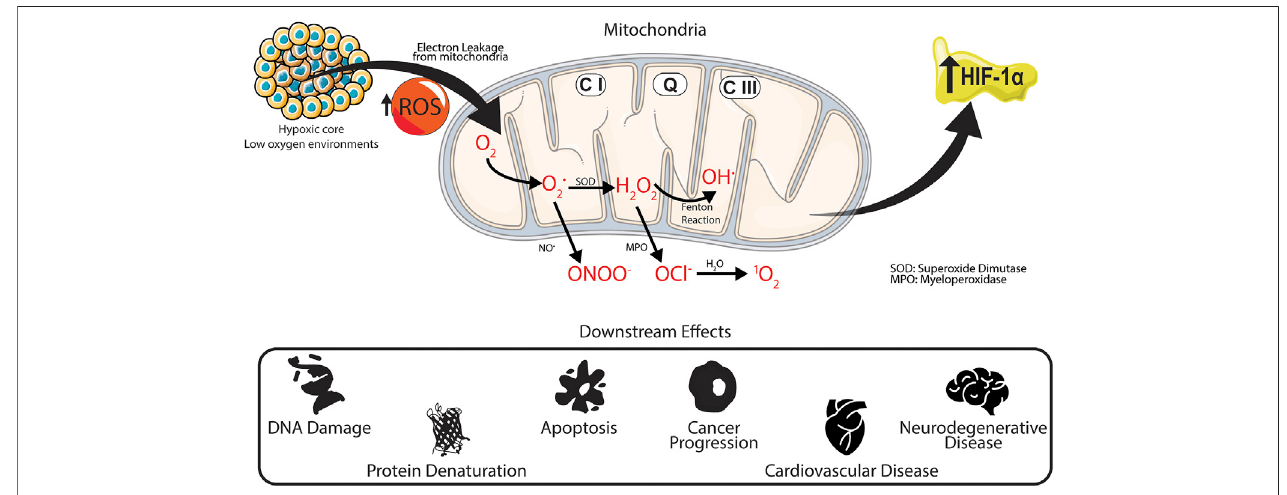
FIGURE 2 | Downstream effects of hypoxia in situ . Under low oxygen environments production of superoxides from complex III increases within the mitochondria. ThesuperoxidethenreactstoformdifferentROSproducts,increasingtheupregulationofHIF-1 α ,whichhasbeenlinkedtovariousintracellularandextracellulardamage associated with several physiological and neurological